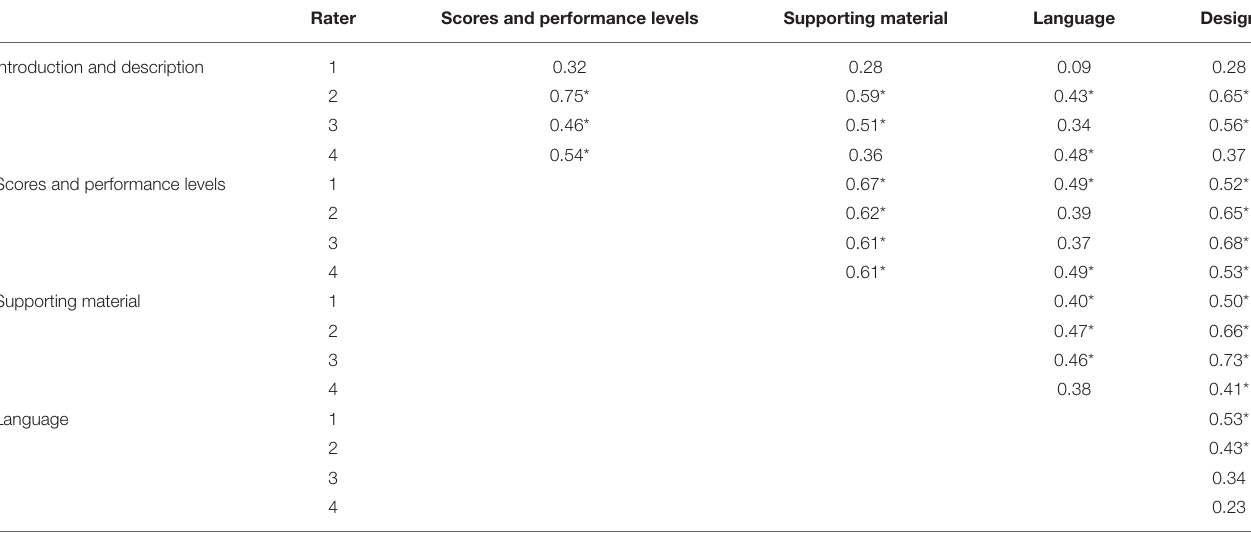
TABLE 2 | Spearman rank-order correlations between domains by rater.